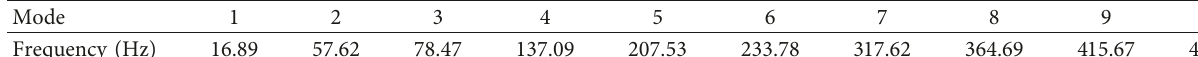
Figure 2: A planar truss with 41 elements (figures within brackets are the node number, and other figures are element number). Table 1: First ten modal frequencies of the intact structure.